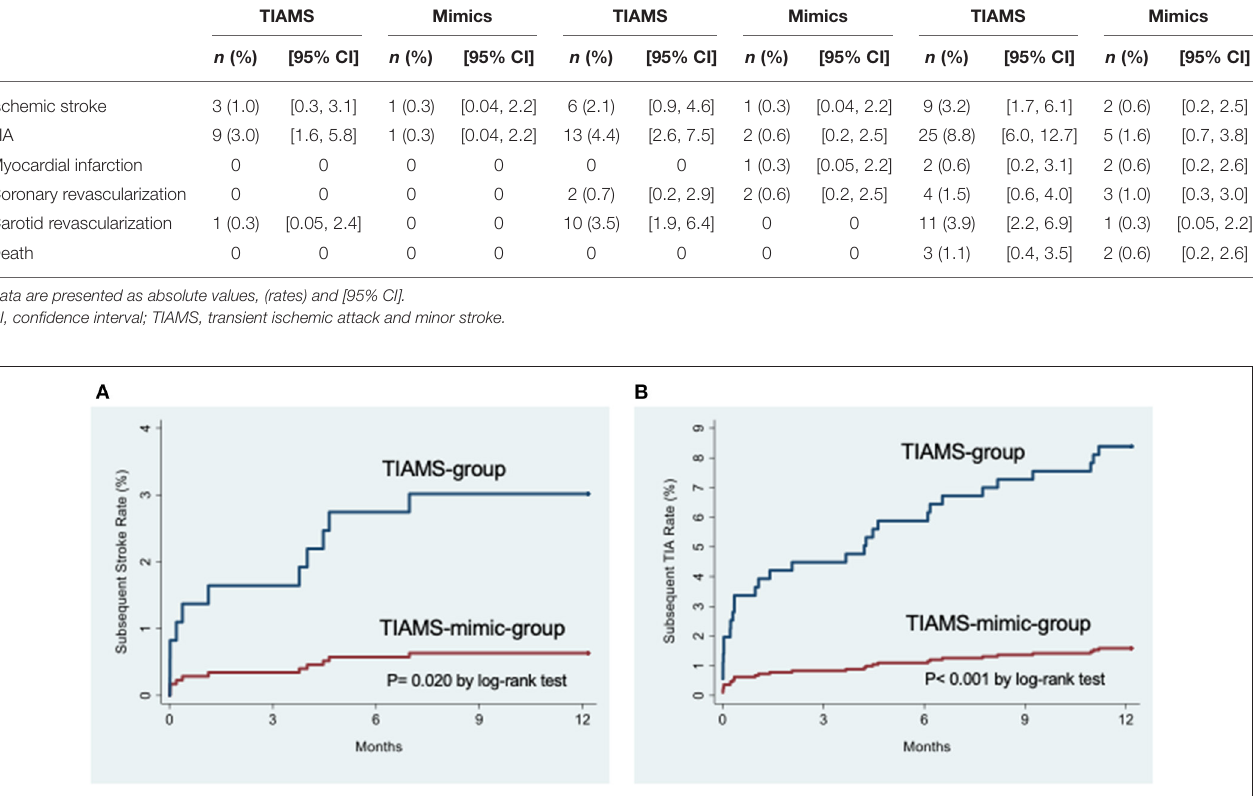
FIGURE 2 | (A) Cumulative incidence functions for subsequent stroke from the time of the index event. (B) Cumulative incidence functions for subsequent transient ischemic attack from the time of the index